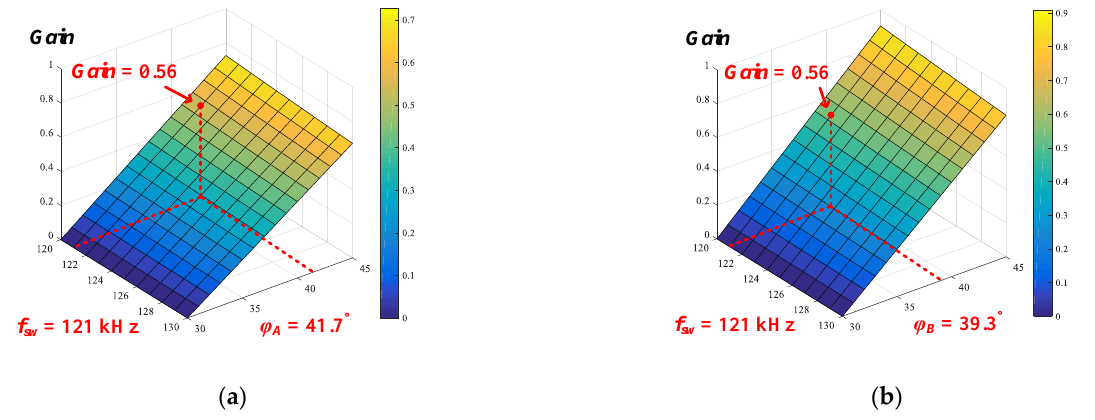
Figure 16. Simulation results of switching frequency versus phase shift degree at a 100% output load: ( a ) module A with L rA = 20 μH, ( b ) module B with L rB = 16 μH.